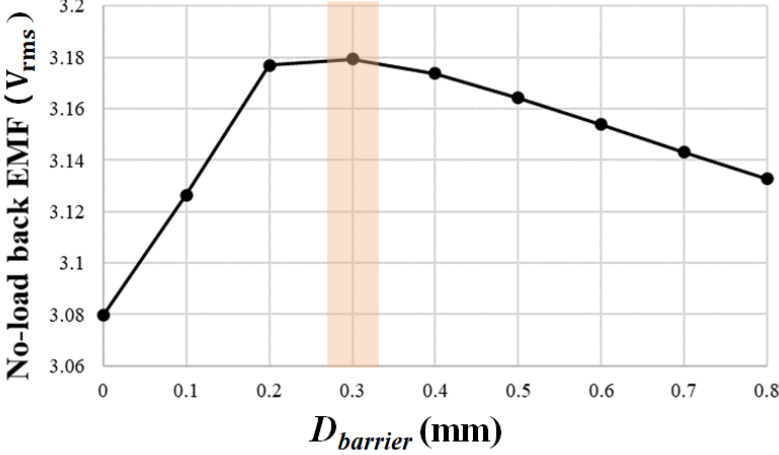
Figure 9. No-load back EMF variation with D barrier (4000 rpm).